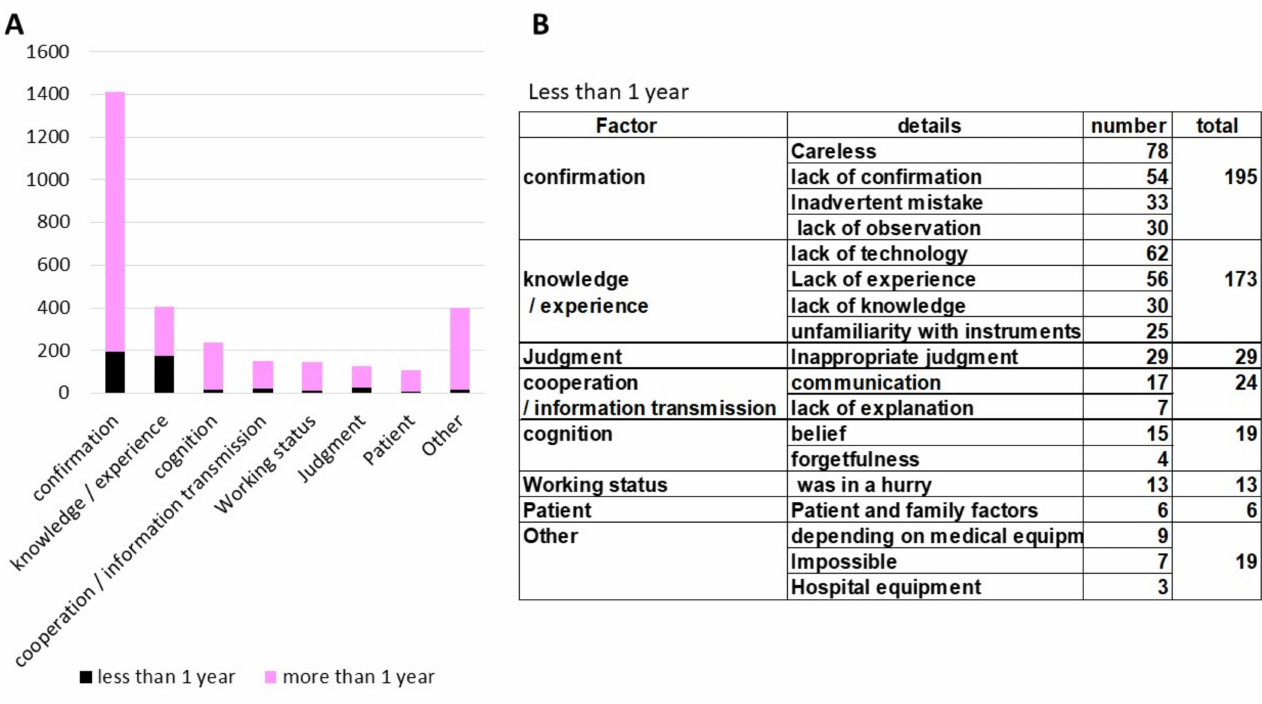
Figure 5. ( A ) Comparison of factors of incidents reported by dental care workers with less and more than one year of work experience. ( B ) The cause of the incidents in dental care workers with less than one year of work